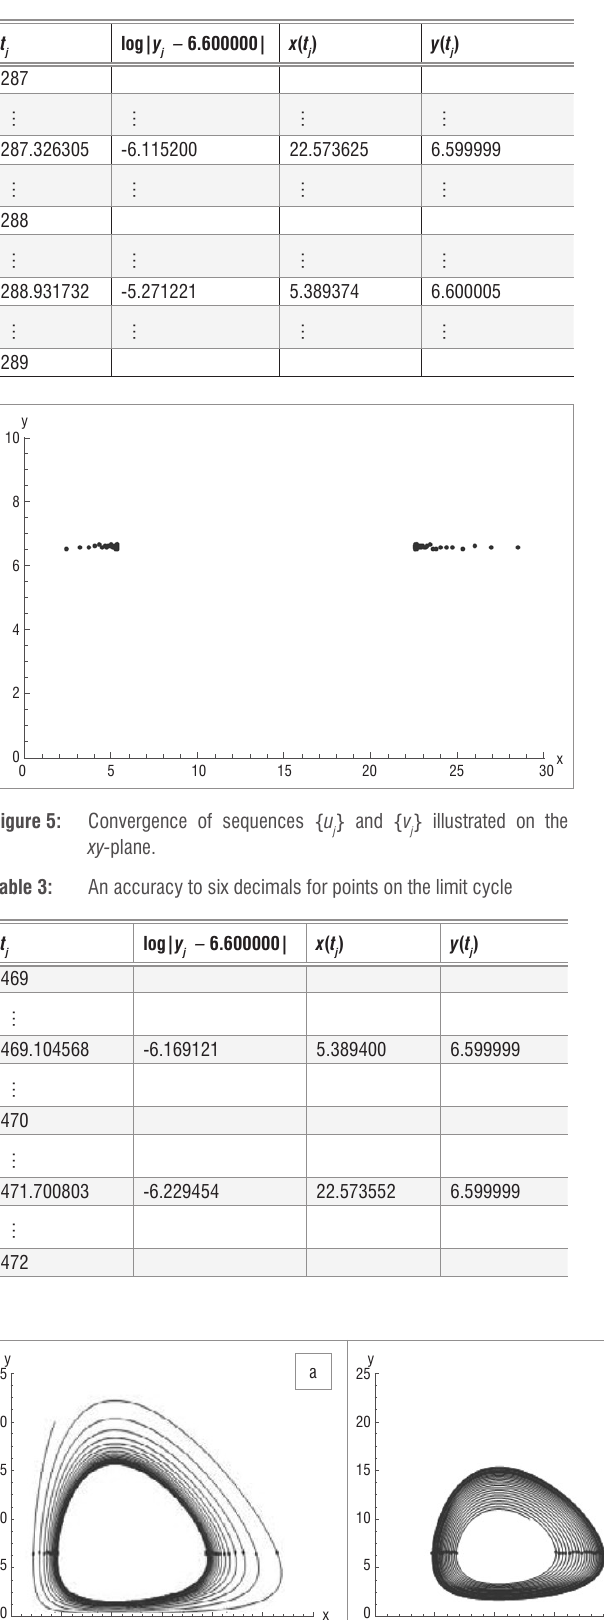
An accuracy to six decimals for points on the limit cycle